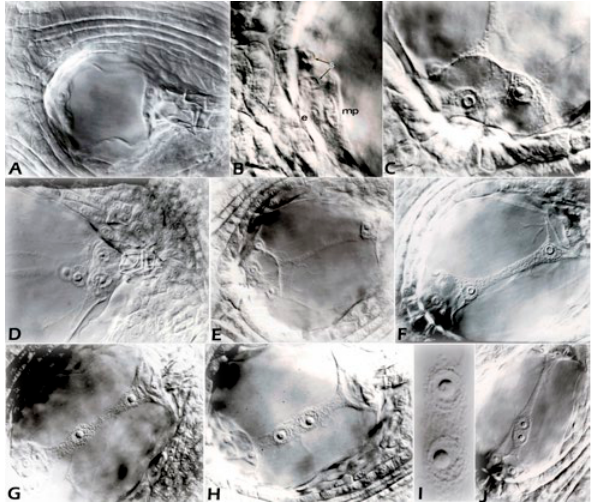
Figure 1. Early development and migration of polar nuclei in Z. drummondii . The micropylar end is to the left or down in each pic- ture. A. Tetranucleate embryo sac with nuclei side by side at each end. B. Flattened nuclei soon after telophase at the micropylar end, indicating orthogonal spindles; e, predicted egg nucleus; mp, predicted micropylar polar nucleus; s, predicted synergids, based on frequently occurring positions in the mature egg apparatus. C. More mature, fully cellular egg apparatus with egg nucleus (at left) unusually close to the micropylar end of the egg cell. The filiform apparatus of a synergid (right) appears feltlike or fibrillar. D. Mature antipodal apparatus in contact with the hypostase, whose walls are thickened and birefringent. The migrated but unfused polar nuclei lie immediately to the left. E. Inception of the central column. There are also smaller, variously oriented cytoplasmic strands that appear (with light microscopy) to have intruded into a previously uninterrupted central vacuole. The egg apparatus of this embryo sac appeared in C. F. The central column has reached full thickness.